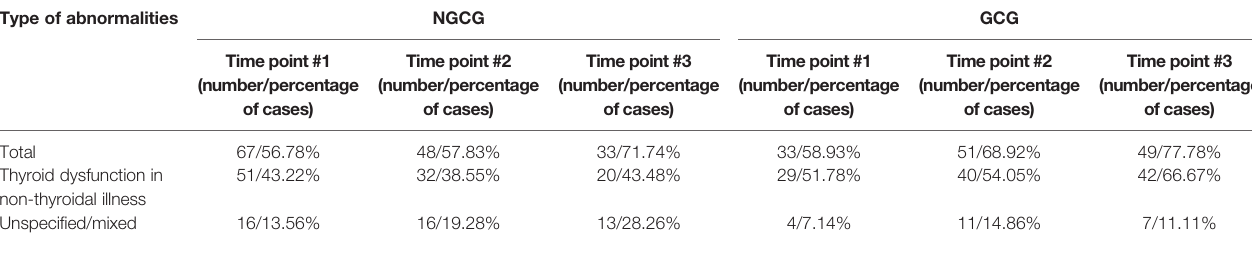
TABLE 2 | Pattern of thyroid function abnormalities throughout the observation